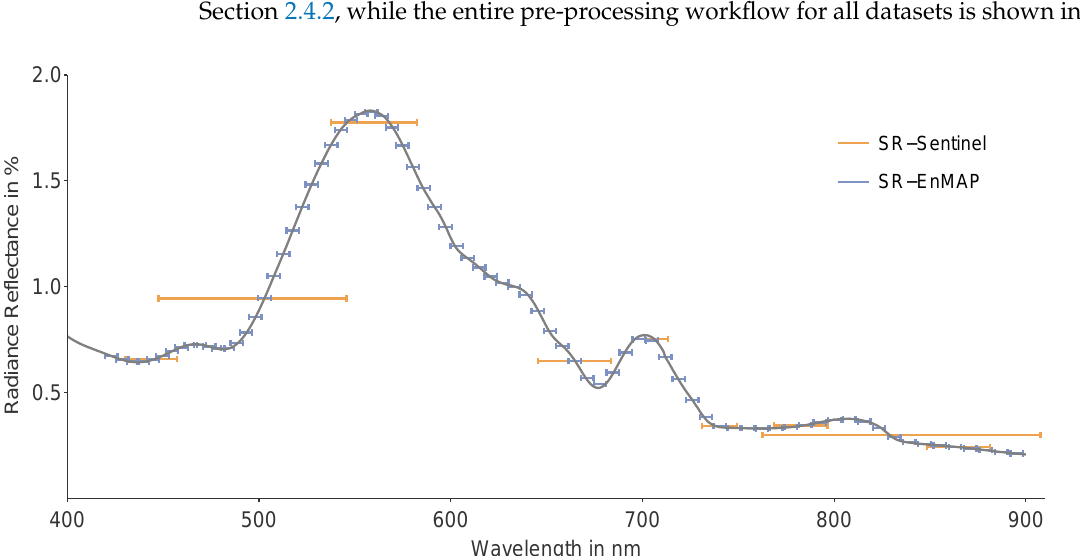
Figure 4. Visualization of the two different downsampled spectral resolutions. The spectral resolution of the Sentinel-2 mission (orange) is referred to as SR-Sentinel , and the spectral resolution of the EnMAP mission (blue) as SR-EnMAP . The grey line represents a selected WASI-generated simulation spectrum with a chlorophyll a value of 51µgL − 1 , a concentration of suspended materials type I of 7.8mgL − 1 , and a sandy bottom substrate. The additonal WASI parameters are set to the (default) values according to Tables 2 and